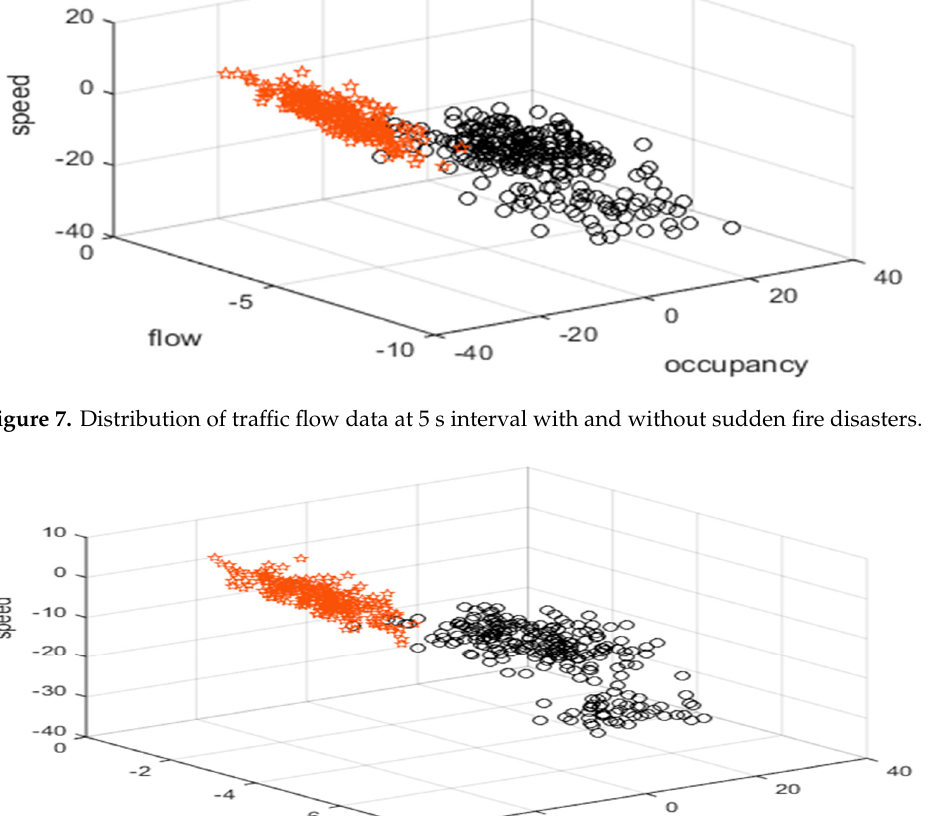
Figure 8. Distribution of traffic flow data at 10 s interval with and without sudden fire disasters.